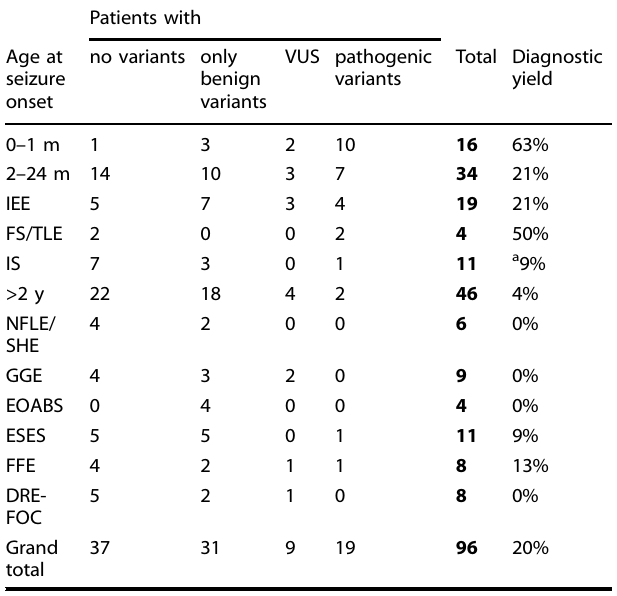
Table 4. Variant yield by age of onset and epilepsy syndrome Patients with